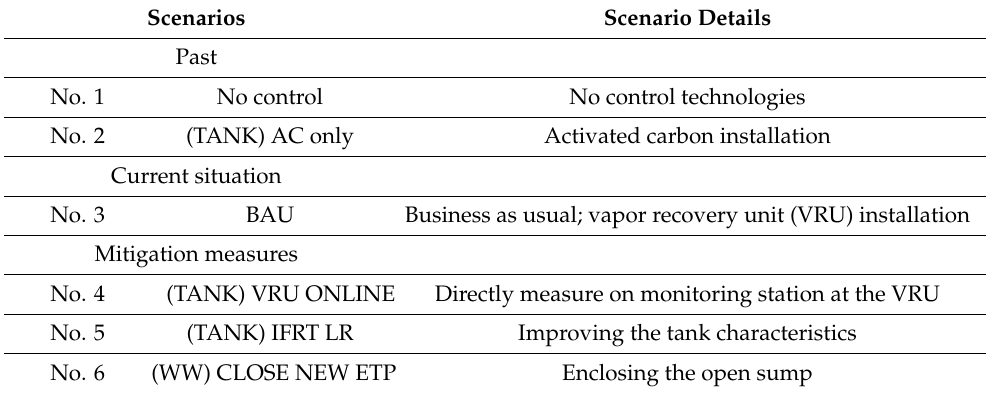
Table 3. Detailed scenario